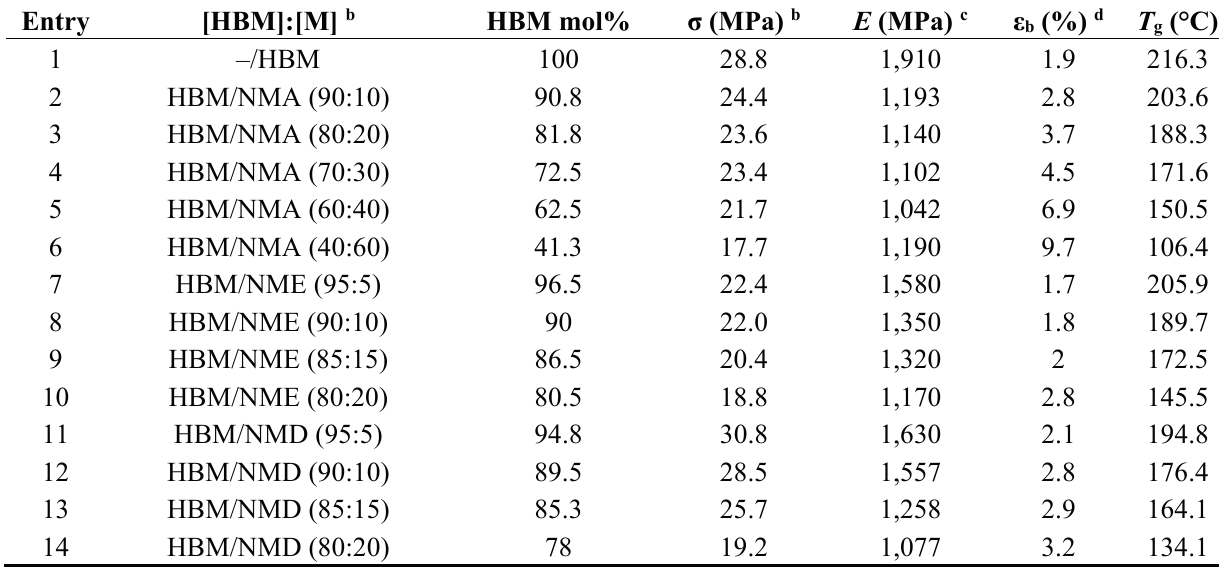
Table 2. Tensile Properties of the COPs films a